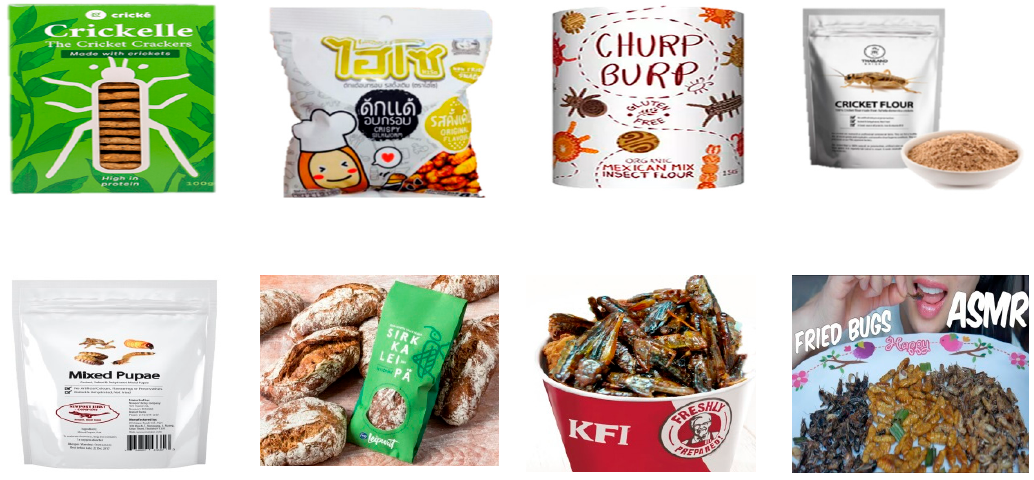
Figure A1. Insect food display